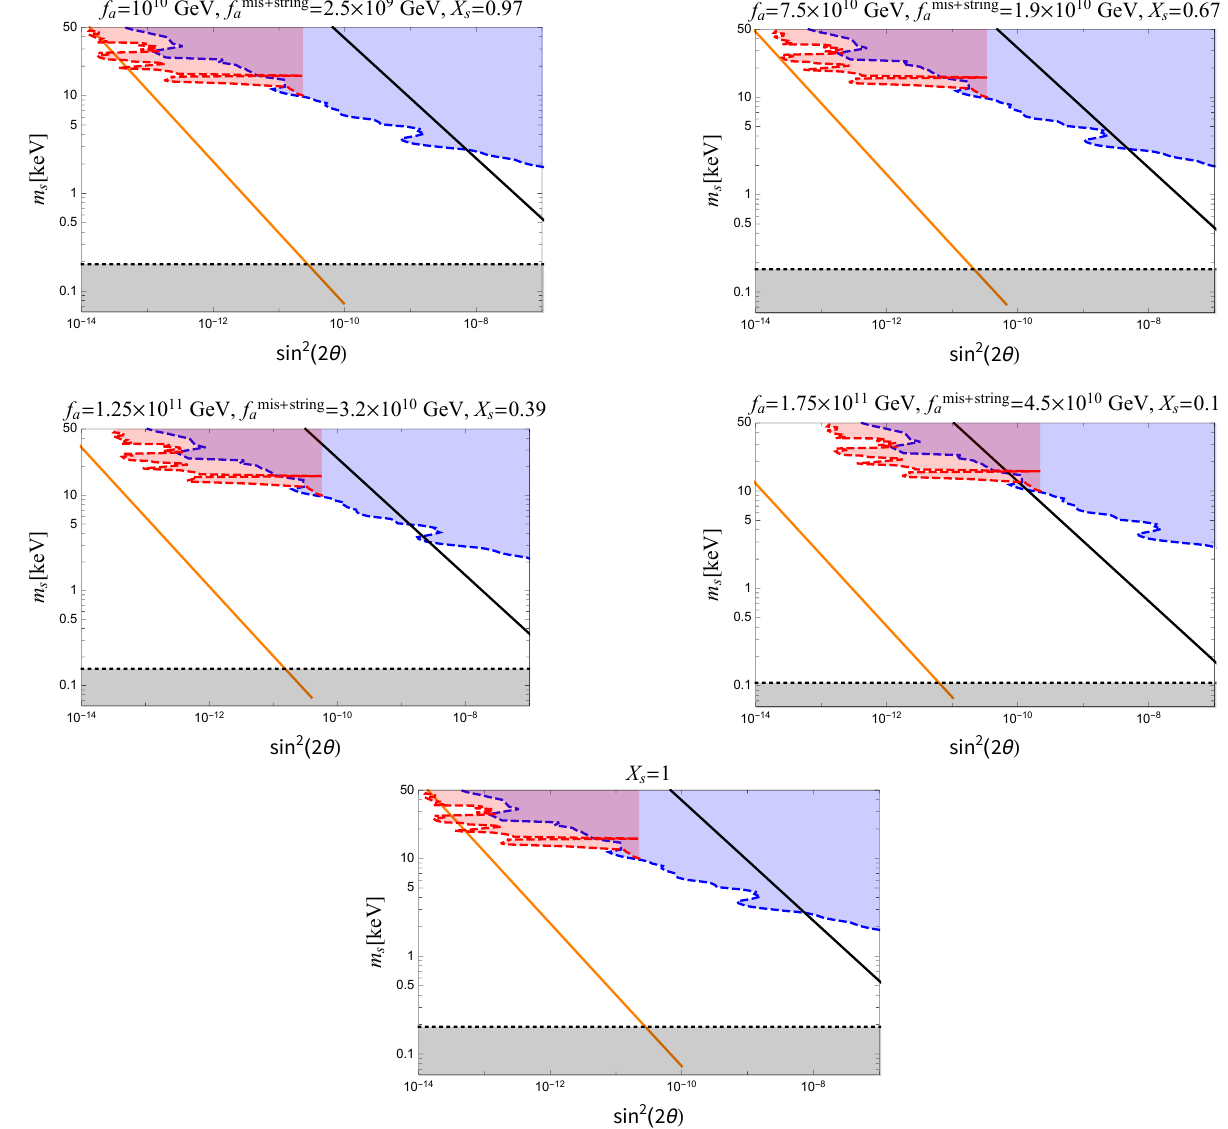
Figure 5. The upper and lower lines of Figure 4 (here depicted in solid black and orange, respectively) compared with the X-ray and phase-space bounds discussed in Section 4 (dashed lines). The X-ray bounds are the upper ones in blue [42] and red [81], while the phase-space ones are the lower ones in black. In this figure, we also provide the corresponding plot for X s = 1 (the bottom one, see Ref. [42] for a